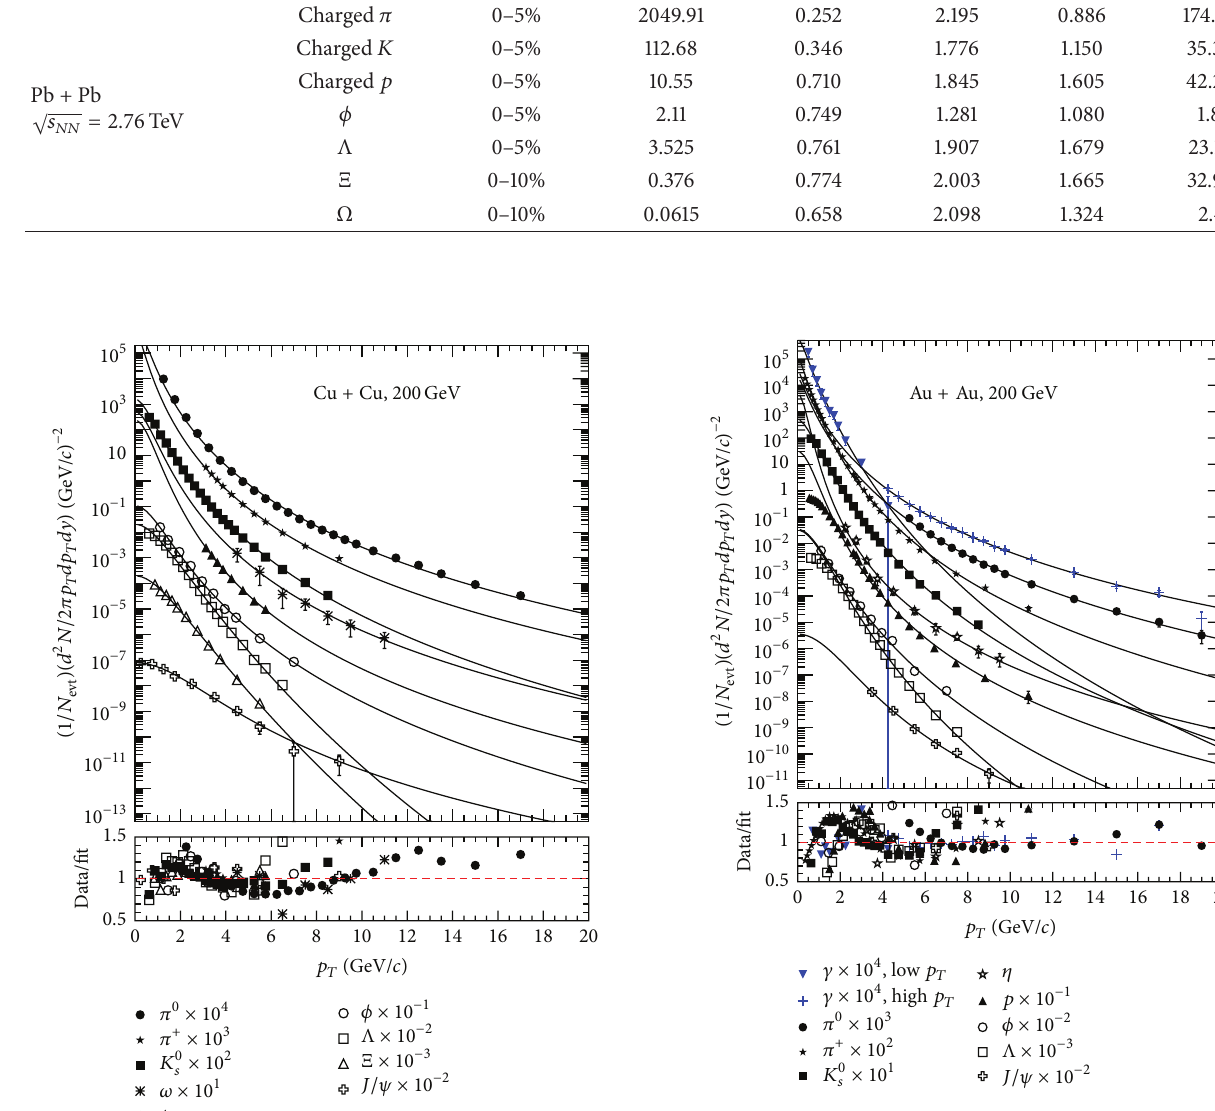
Figure 5: The data are from [11, 32, 46, 48–52] for Au + Au at = 200 GeV. The curves are the analytical results with Tsallis √𝑠 𝑁𝑁 distribution Equation (10). The corresponding fitting parameters and 𝜒 2 /ndf are given in Table 1. For a better visualization both the data and the analytical curves have been scaled by a constant as indicated. The ratios of data/fit are shown at the